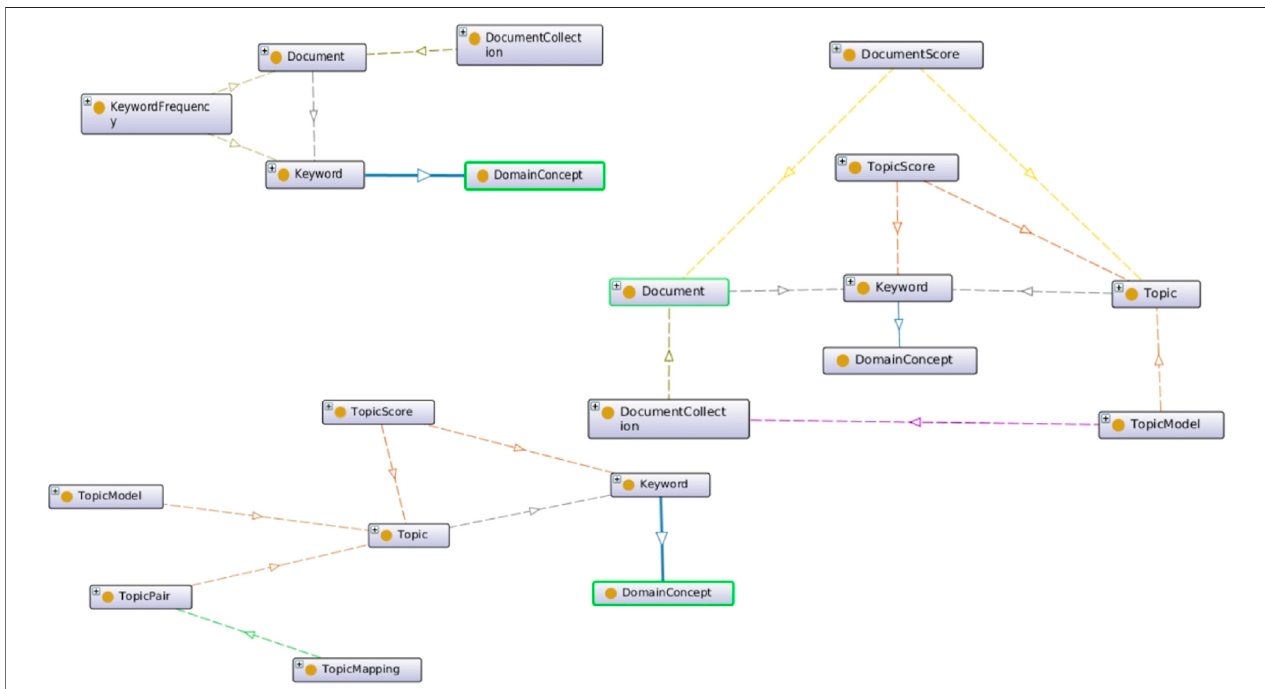
FIGURE 3 | Three components of our topic model ontology (TMO) are (A) classes for representing document collections (top left) , (B) classes to encode document and topic relationships (middle right) , and (C) classes to represent cross-domain mappings (bottom left) .